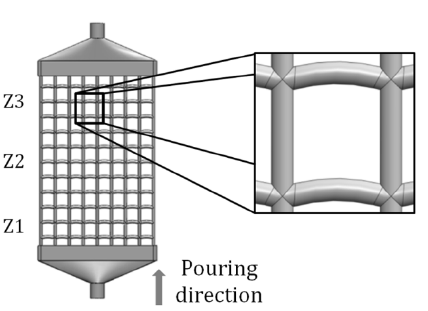
Figure 1. Developed geometries used in this study.